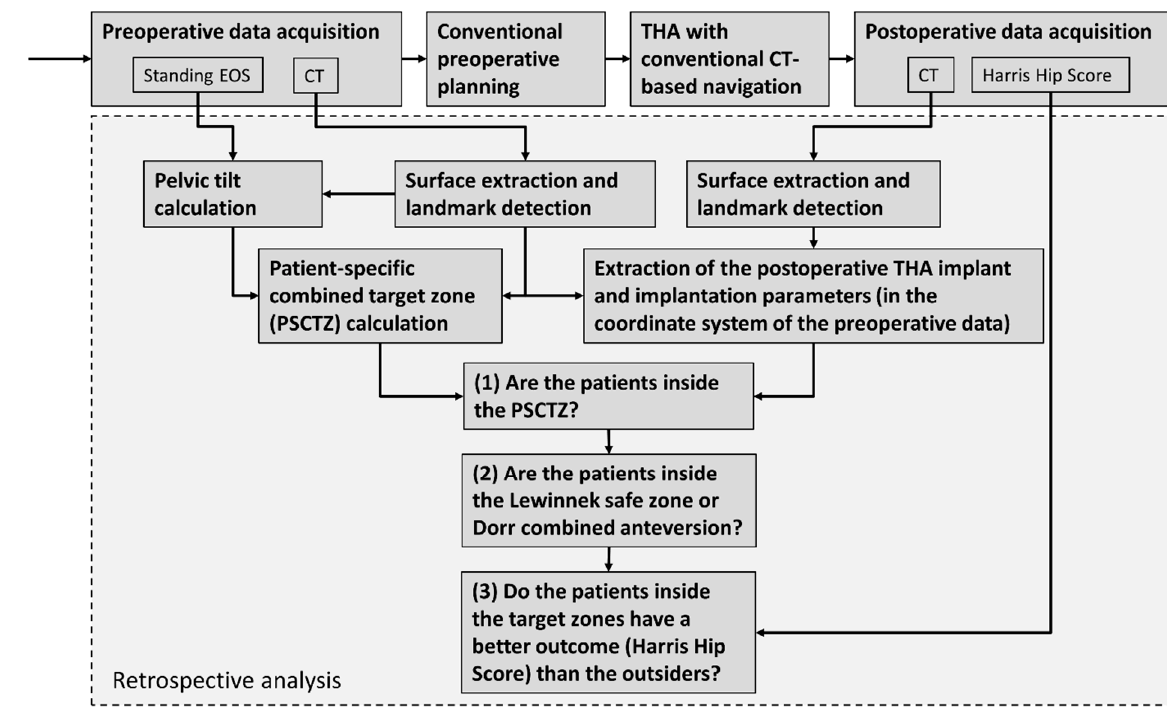
Figure 6. Overview of the retrospective study design.